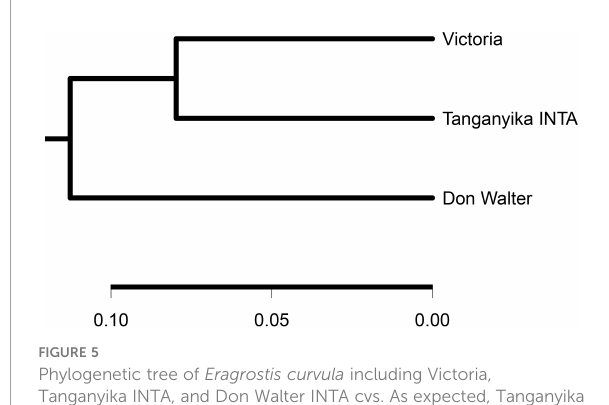
FIGURE 4 Differentially enriched GO terms of E. curvula pangenome variable genes. p-value cutoff was set in 0.05. The GO terms in the were sorted based on p-value. Three terms related to reproduction were found enriched.